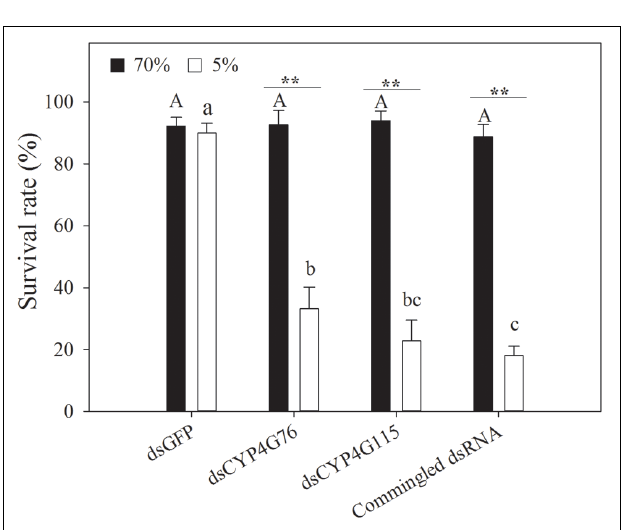
FIGURE 6 | Effect of RNAi suppression of CYP4G76 and CYP4G115 on the survival rate of Nilaparvata lugens nymph following desiccation treatment (RH < 5% for 24 h). Commingled dsRNA contained CYP4G76 and CYP4G115 (1:1). Mean ± SE was calculated from five biological replicates, and each biological replicate contained thirty fourth instar N. lugens nymphs . Different capital and lowercase letters in each figure showed the significant difference (ANOVA, LSD, p < 0.05). ∗∗ in each figure showed significant difference (Student’s t -test, p <